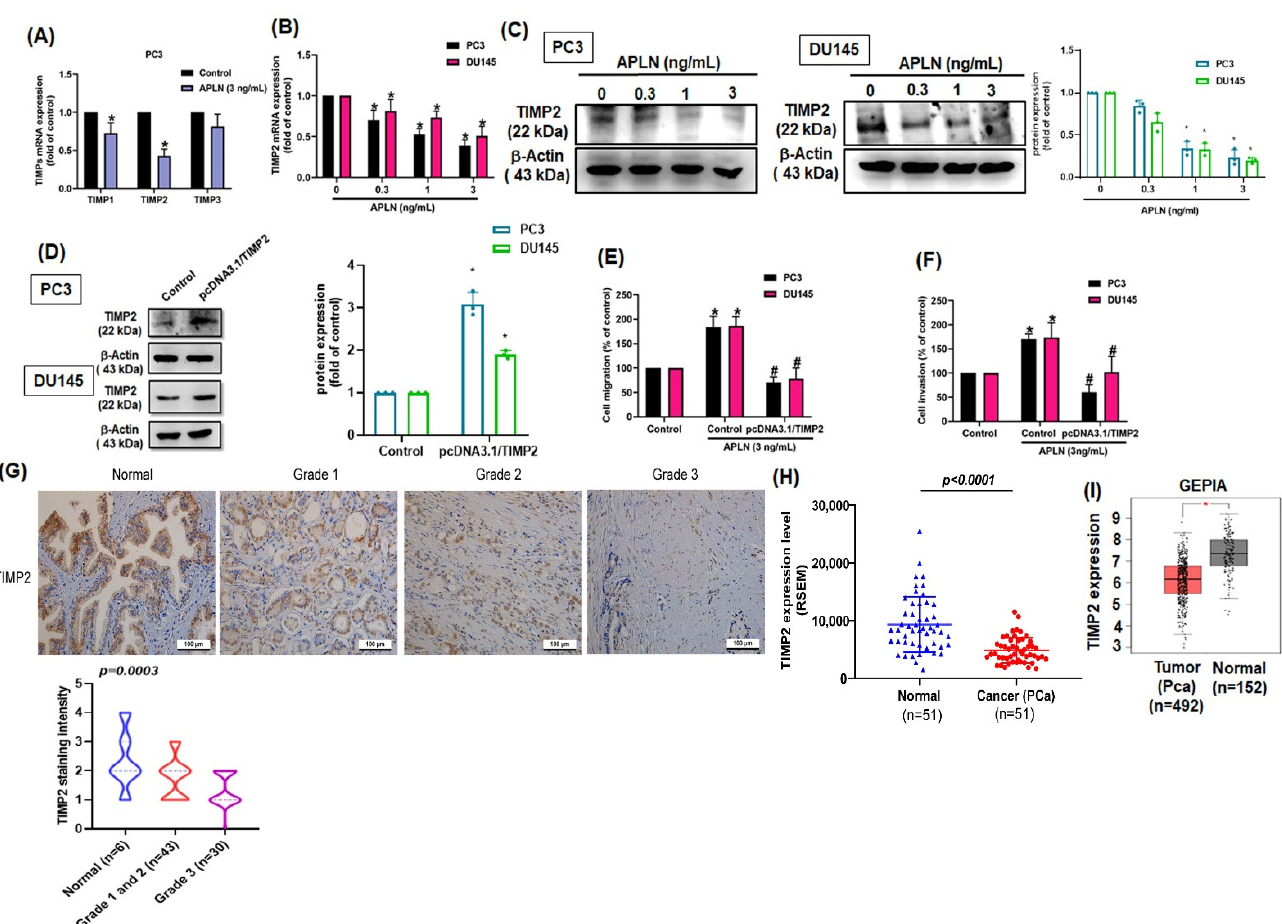
Figure 3. Apelin promotes prostate cancer motility by inhibiting TIMP2 expression. ( A ) PC3 cells were treated with apelin, then TIMP expression was examined by qPCR ( n = 4). ( B , C ) Cells were treated with apelin for 24 h, then TIMP2 expression was examined by qPCR ( n = 4) and Western blot ( n = 3). ( D – F ) Cells were transfected with TIMP2 cDNA followed by stimulation with apelin, then cell migration ( n = 4), invasion ( n = 4) and levels of TIMP2 expression ( n = 3) were examined. ( G ) Representative images of IHC staining for TIMP2 in tissue samples from healthy individuals and prostate cancer patients. ( H , I ) Tissue samples from the TCGA and GEPIA databases were measured for levels of TIMP2 in normal and prostate cancer tissue samples. Dots of bar graph means the number of patient. * p < 0.05 compared with the control group; # p < 0.05 compared with the apelin-treated group. Scale bar for all images is 100 µ